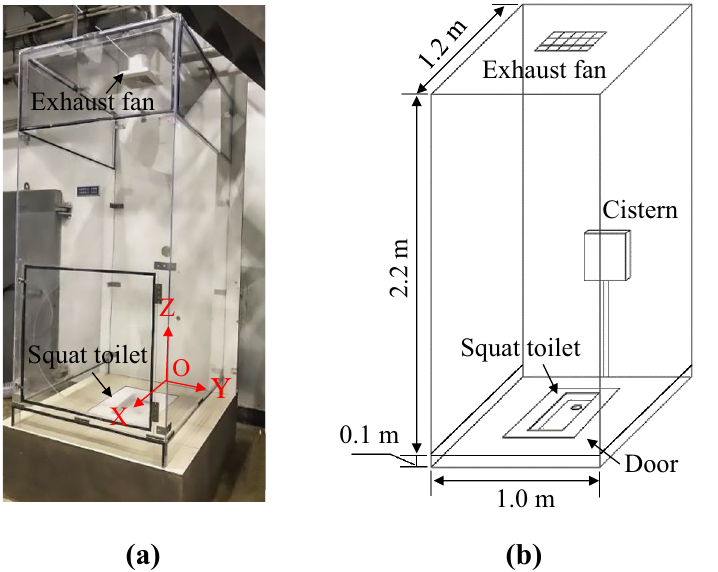
Figure 10. A lavatory mockup with a squat toilet inside: ( a ) photograph of the lavatory, ( b ) schematic of the